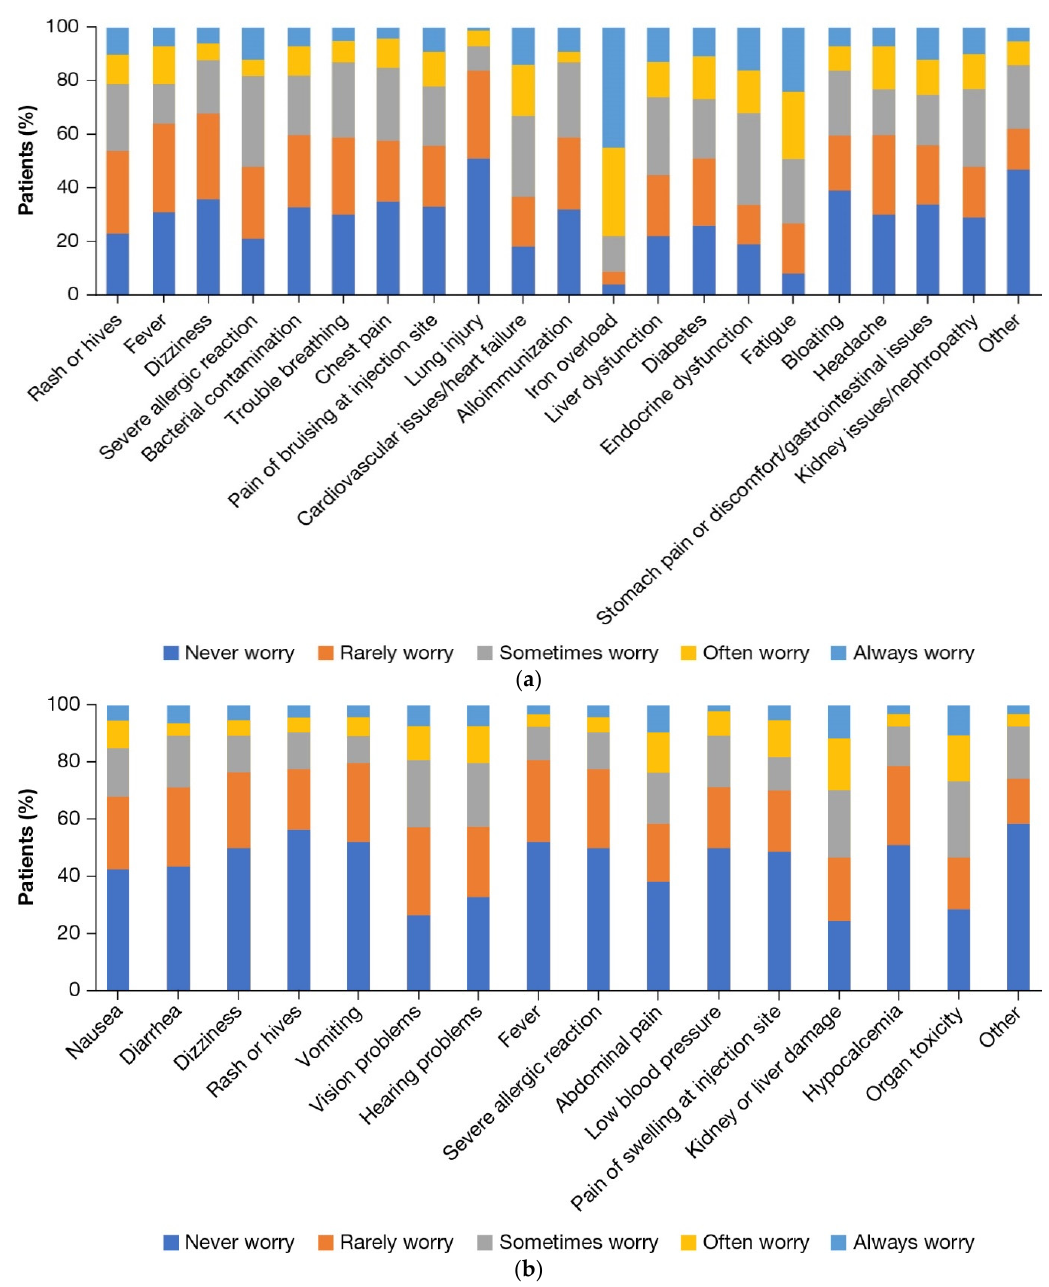
Figure 4. Psychological outcomes. ( a ) Frequency of worrying about transfusion side effects; ( b ) Frequency of worrying about ICT side effects. Patients indicated how frequently they wor- ried about predefined ICT-related side effects in the past 6 months (5-point scale from “never worry” to “always worry”). ICT: iron chelation